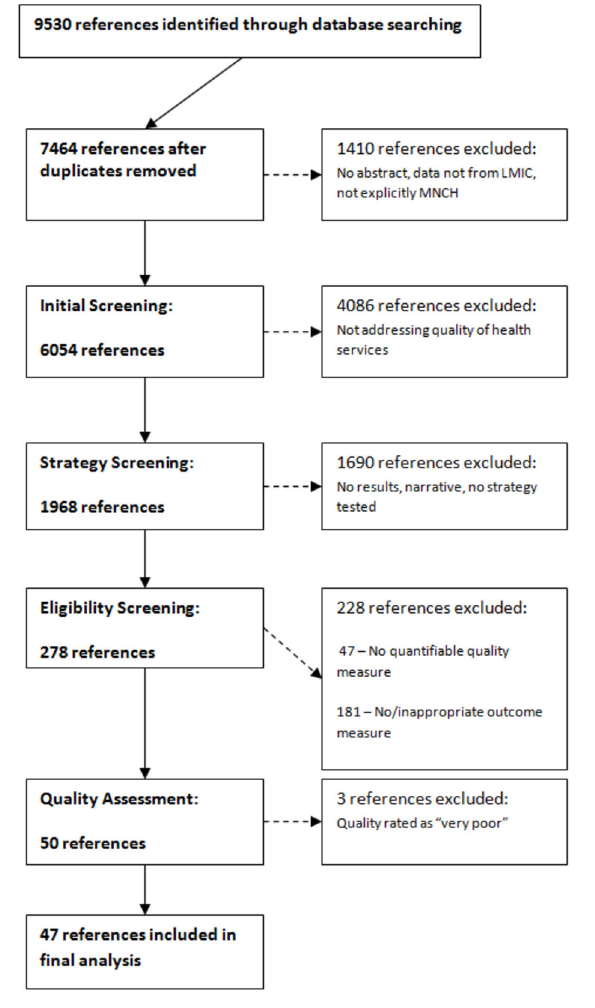
Figure 2. Study selection